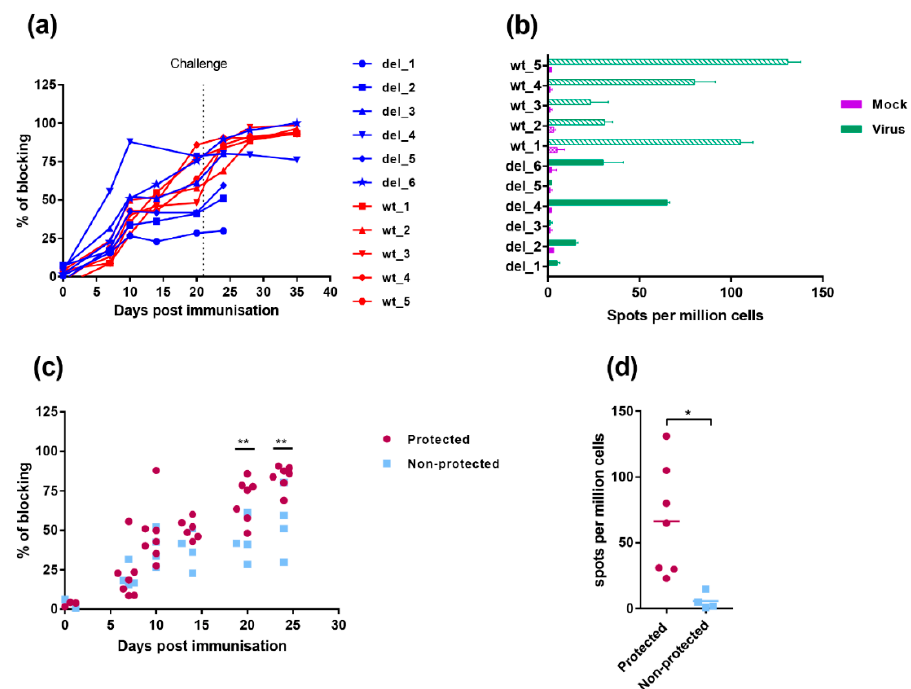
Figure 7. Immune responses in pigs immunised with OURT88 / 3 and OURT88 / 3 ∆ I329L. Panel ( a ) shows anti-ASFV antibodies detected by a blocking ELISA at di ff erent days post-immunisation. The y-axis shows the percentage of blocking, and the x-axis shows days post-immunisation. The results for pigs immunised with OURT88 / 3 are shown in red (wt_1–5), with OURT88 / 3 ∆ I329L in blue (del_1–6). Panel ( c ) compares antibody response in pigs that survived challenge (protected, magenta) with those that did not survive (non-protected blue). Panel ( b ) shows the numbers of IFN- γ -producing cells detected by ELIspot assay following the stimulation of lymphocytes with ASFV. The x-axis shows IFN- γ -producing cells (spots) per million of cells detected, and the y-axis shows the source of samples. The results from mock-treated (purple) and ASFV-stimulated lymphocytes (green) are shown. Panel ( d ) compares numbers of IFN- γ -producing cells detected in protected versus non-protected pigs. Asterisks indicate statistically significant di ff erences between groups (* p ≤ 0.05; ** p ≤